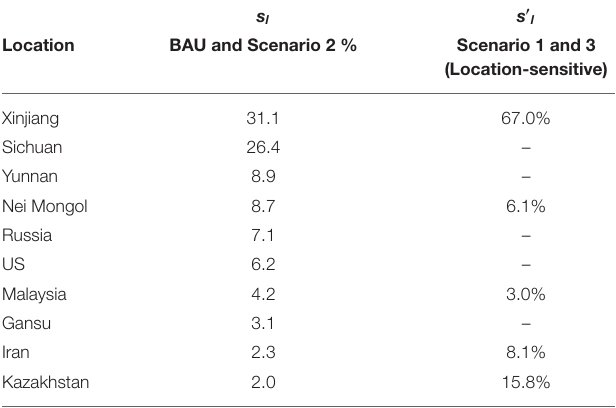
TABLE 1 | Distribution of mining locations s l and s ′ l in different scenarios. s l s ′ l